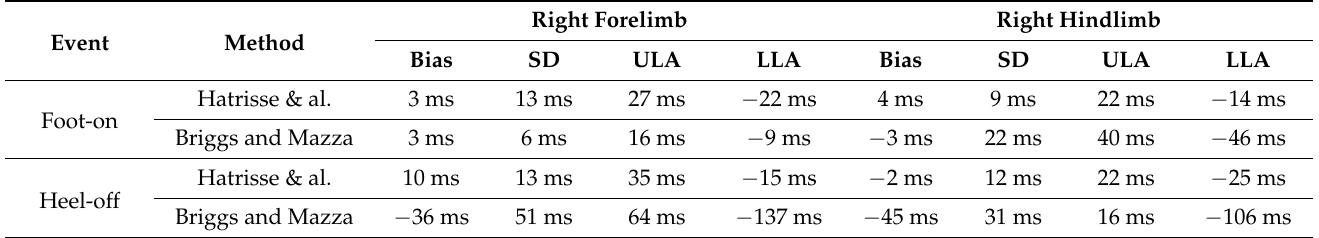
Table 5. Bland–Altman comparison (in milliseconds) of the reference foot-on and heel-off events and the foot-on and heel-off events detected with the method from Briggs and Mazza [9] and our method from the cannon bone data. Accuracy (bias), precision (SD), and upper/lower limits of agreement (ULA and LLA) were indicated for the straight-line-on-hard-ground condition, and for the right forelimb and right hindlimb. For both events (foot-on and heel-off), the table shows results obtained from the same dataset with our method (Hatrisse & al.) and the Briggs and Mazza method